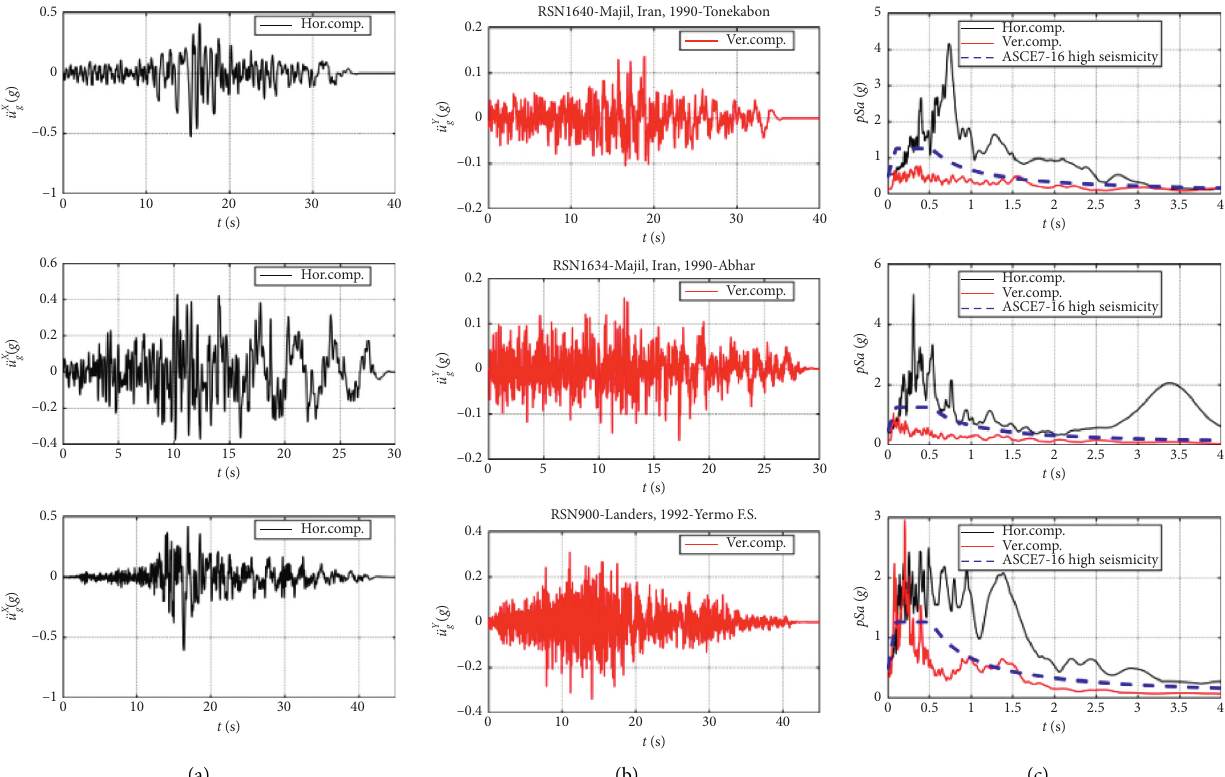
Figure 17: Ensemble of the scaled seismic records used as the base excitations: (a) (left) horizontal components, (b) (middle) vertical components and (c) (right) comparison of pseudo-acceleration spectra with the target spectrum.